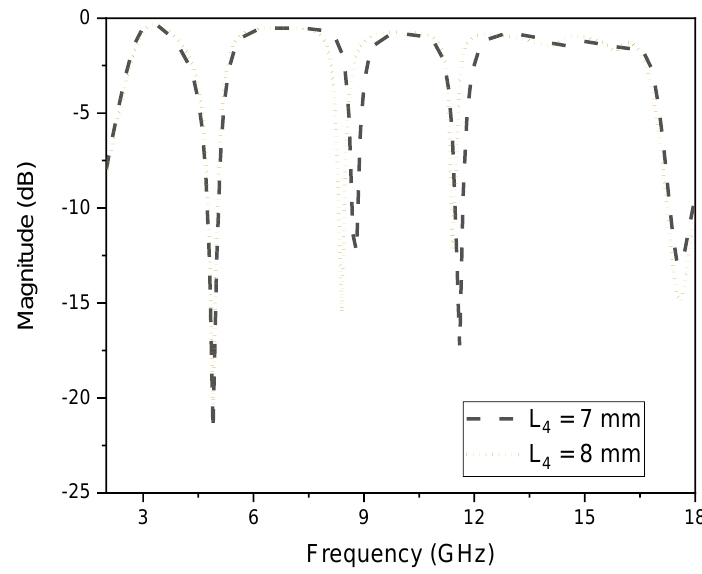
Figure 14. Validation of second band control w.r.t L 4 .